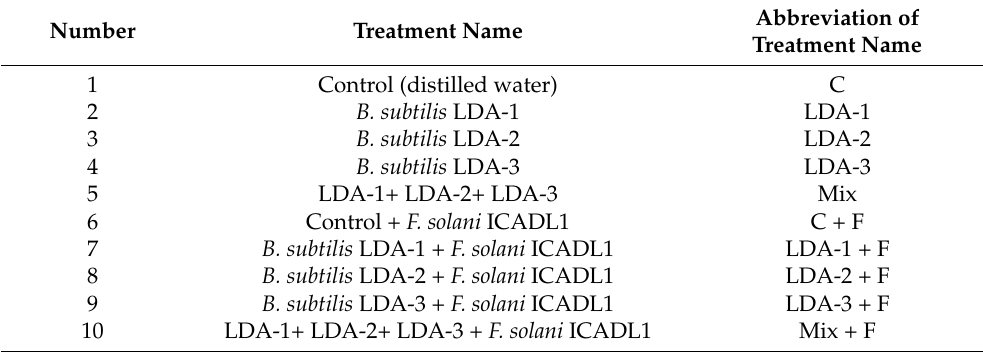
Table 2. Treatments and their